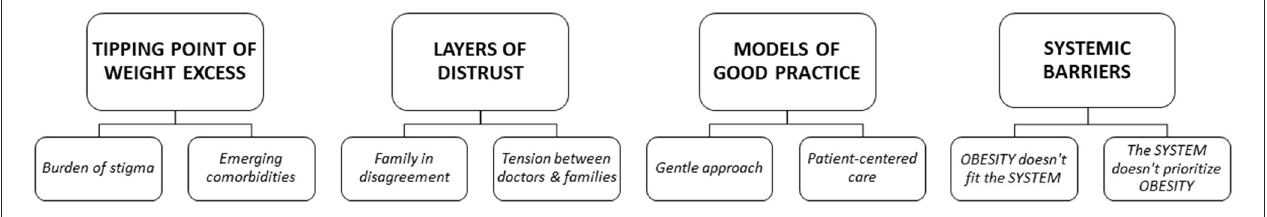
FIGURE 1 | Main themes and sub-themes